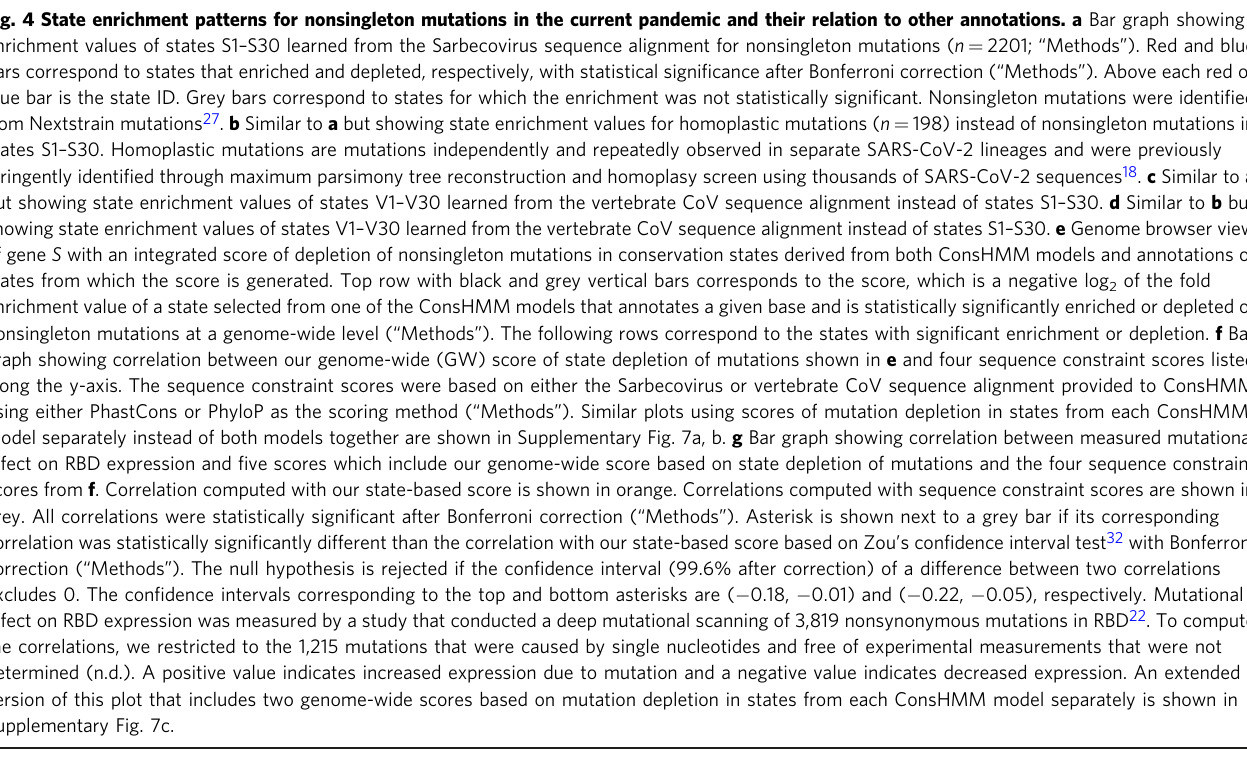
Fig. 4 State enrichment patterns for nonsingleton mutations in the current pandemic and their relation to other annotations. a Bar graph showing enrichment values of states S1 – S30 learned from the Sarbecovirus sequence alignment for nonsingleton mutations ( n = 2201; “ Methods ” ). Red and blue bars correspond to states that enriched and depleted, respectively, with statistical signi fi cance after Bonferroni correction ( “ Methods ” ). Above each red or blue bar is the state ID. Grey bars correspond to states for which the enrichment was not statistically signi fi cant. Nonsingleton mutations were identi fi ed from Nextstrain mutations 27 . b Similar to a but showing state enrichment values for homoplastic mutations ( n = 198) instead of nonsingleton mutations in states S1 – S30. Homoplastic mutations are mutations independently and repeatedly observed in separate SARS-CoV-2 lineages and were previously stringently identi fi ed through maximum parsimony tree reconstruction and homoplasy screen using thousands of SARS-CoV-2 sequences 18 . c Similar to a but showing state enrichment values of states V1 – V30 learned from the vertebrate CoV sequence alignment instead of states S1 – S30. d Similar to b but showing state enrichment values of states V1 – V30 learned from the vertebrate CoV sequence alignment instead of states S1 – S30. e Genome browser view of gene S with an integrated score of depletion of nonsingleton mutations in conservation states derived from both ConsHMM models and annotations of states from which the score is generated. Top row with black and grey vertical bars corresponds to the score, which is a negative log 2 of the fold enrichment value of a state selected from one of the ConsHMM models that annotates a given base and is statistically signi fi cantly enriched or depleted of nonsingleton mutations at a genome-wide level ( “ Methods ” ). The following rows correspond to the states with signi fi cant enrichment or depletion. f Bar graph showing correlation between our genome-wide (GW) score of state depletion of mutations shown in e and four sequence constraint scores listed along the y-axis. The sequence constraint scores were based on either the Sarbecovirus or vertebrate CoV sequence alignment provided to ConsHMM using either PhastCons or PhyloP as the scoring method ( “ Methods ” ). Similar plots using scores of mutation depletion in states from each ConsHMM model separately instead of both models together are shown in Supplementary Fig. 7a, b. g Bar graph showing correlation between measured mutational effect on RBD expression and fi ve scores which include our genome-wide score based on state depletion of mutations and the four sequence constraint scores from f . Correlation computed with our state-based score is shown in orange. Correlations computed with sequence constraint scores are shown in grey. All correlations were statistically signi fi cant after Bonferroni correction ( “ Methods ” ). Asterisk is shown next to a grey bar if its corresponding correlation was statistically signi fi cantly different than the correlation with our state-based score based on Zou ’ s con fi dence interval test 32 with Bonferroni correction ( “ Methods ” ). The null hypothesis is rejected if the con fi dence interval (99.6% after correction) of a difference between two correlations excludes 0. The con fi dence intervals corresponding to the top and bottom asterisks are ( − 0.18, − 0.01) and ( − 0.22, − 0.05), respectively. Mutational effect on RBD expression was measured by a study that conducted a deep mutational scanning of 3,819 nonsynonymous mutations in RBD 22 . To compute the correlations, we restricted to the 1,215 mutations that were caused by single nucleotides and free of experimental measurements that were not determined (n.d.). A positive value indicates increased expression due to mutation and a negative value indicates decreased expression. An extended version of this plot that includes two genome-wide scores based on mutation depletion in states from each ConsHMM model separately is shown in Supplementary Fig.